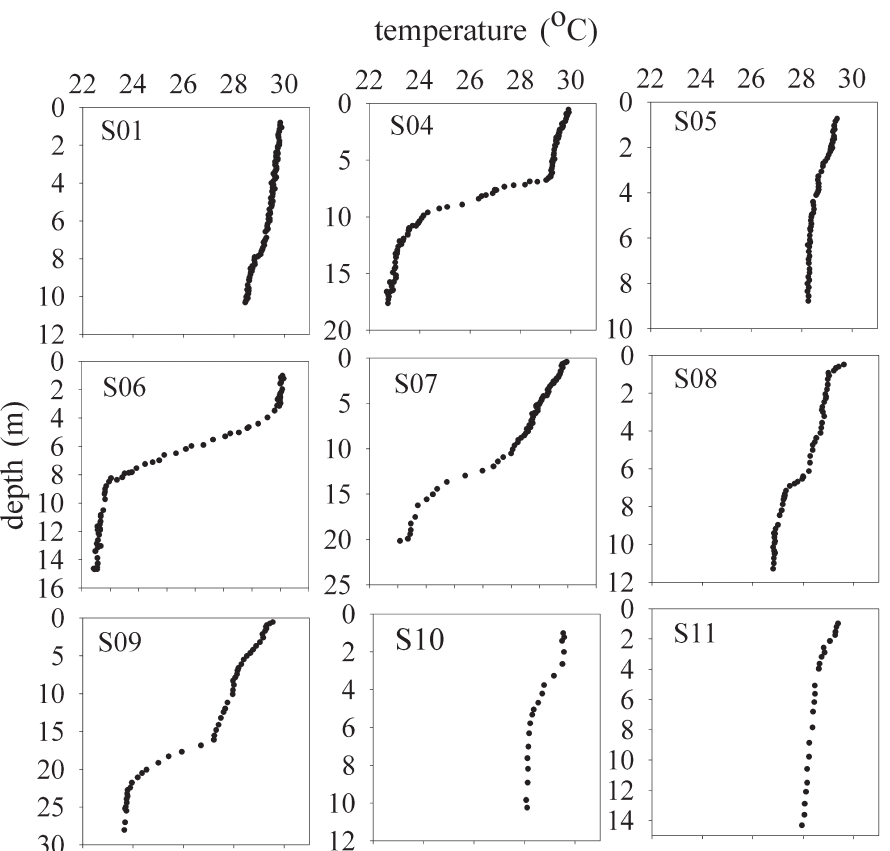
Fig . 3. – Vertical profiles of temperature at station S01, S04, S05, S06, S07, S08, S09, S10 and S11 in